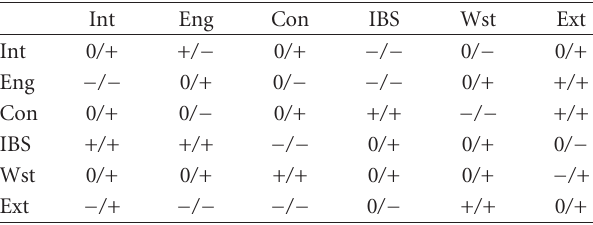
Table 3: Direct utility sign matrix (Sign D )/integral utility